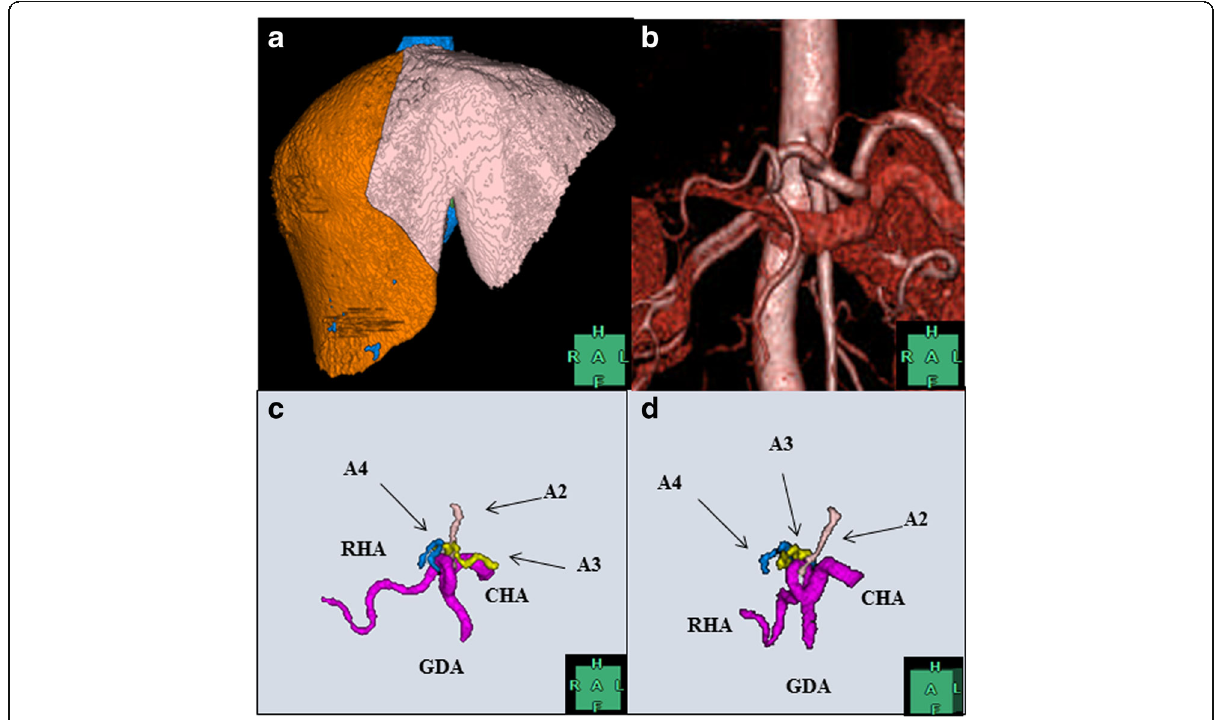
Fig. 1 Donor hepatectomy simulation using the 3D CT software by region-growing method, based on dynamic helical CT of the liver. a The predicted volume of the total liver was 1056 mL, consisting of the right liver (653 mL) and the left liver with the middle hepatic vein (403 mL). b The 3D CT angiography showing no anatomical structure of the LHA and MHA. The simulation using the 3D CT software by region-growing method showing the segment II, III, and IV arteries (A2, A3, and A4 with arrows , respectively) individually originating from the proper hepatic artery. Images of the artery in c the front view and d the left anterior oblique view. CHA common hepatic artery, GDA gastroduodenal artery, RHA right hepatic